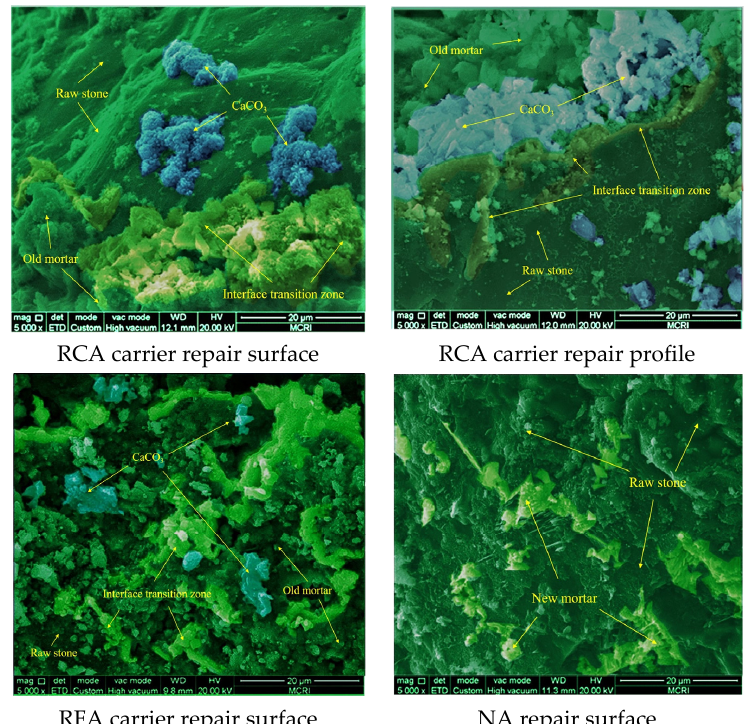
Figure 11. The repair morphology of carrier interface. The sample group with RCA as the carrier had irregular aggregated CaCO 3 distribu- tions on the attached mortar and the ITZ. Among them, only a small amount of repair products appeared on the aggregate due to the dense and smooth texture, and the repair products were sporadically distributed with small particle sizes. The CaCO 3 generated on the attached mortar, as observed through the RCA carrier profile, had the characteristics of large particle sizes and tight aggregation, which indicated that the attached mortar gave a better repair environment for microorganisms. The aggregated CaCO 3 obviously im- proved the resistance to penetration at the concrete cracks, which coincides with the re- sults of impermeability tests. The RFA group specimens show that more adhered mortar from RFA did not make more repair products appear, while the area occupied by cementitious materials (such as C-S-H, etc.) was larger and fewer repair products adhered to the cementitious materials. This may be due to the fact that concrete cracking only had a small chance of occurring in the RFA. The RCA had more microbial volume than the RFA, which had a larger particle size and more adherent mortar monomer volume. Further hydration of the cementitious material with the RFA also inhibited the microbial repair effect, i.e., it hindered microbial contact with O 2 and H 2 O. The lower remediation efficiency and the smaller distribution density of individual microorganisms resulted in smaller particle sizes and distribution areas for the products. It is worth noting that the areas where CaCO 3 was generated are mostly places where less gelling material was present. The NA interface of the specimens was observed to have only a small amount of cementitious material and no repair products on the larger aggregate area. This indicates that the smooth and dense nature of the natural aggregate (NA) is also not conducive to the adhesion of cementitious materials but effectively reduces the pores within the con- crete and improves the overall impermeability. This also indicates that the loose and